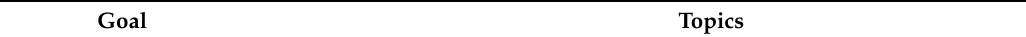
Table 1. SCADA at